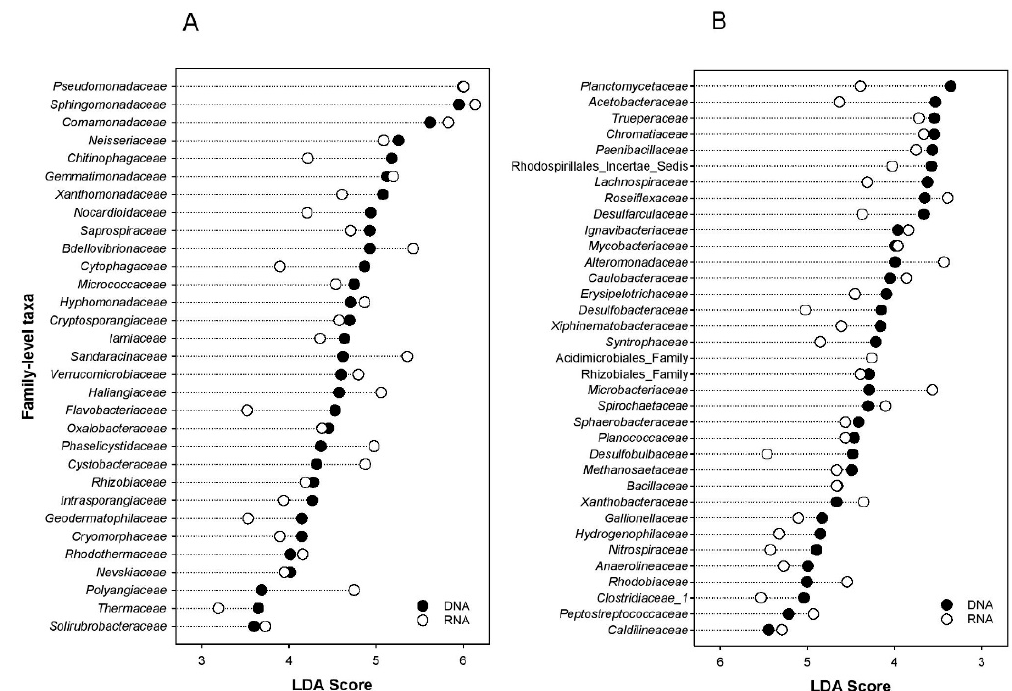
Figure 3. Linear discriminant analysis (LDA) scores on the DNA and RNA levels for families that were more ( A ) or less ( B ) abundant in treatments with ibuprofen relative to non-supplemented controls and displayed a consistent response on the DNA and RNA level.